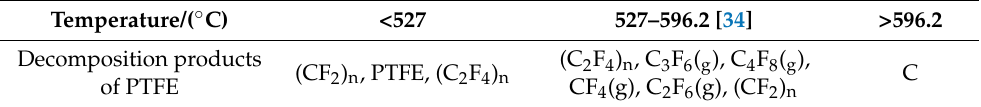
Figure 5. XRD pattern of PTFE at main temperature. ( a ) XRD pattern at 342.2 °C; ( b ) XRD pattern at 560.1 °C; ( c ) XRD pattern at 605.9 °C; ( d ) XRD pattern at 1000 °C. Table 6. Pyrolysis products of PTFE in different temperature ranges.